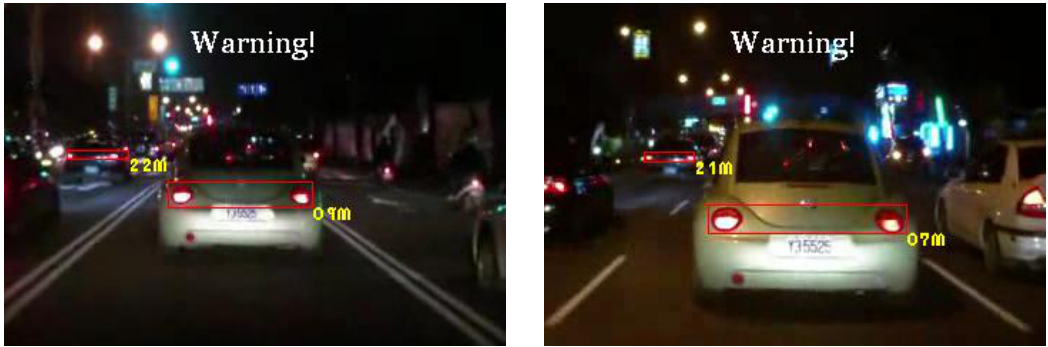
Figure 20. Results of vehicle detection and event determination for a nighttime urban road under normal illumination and congested traffic conditions (Test video 4).